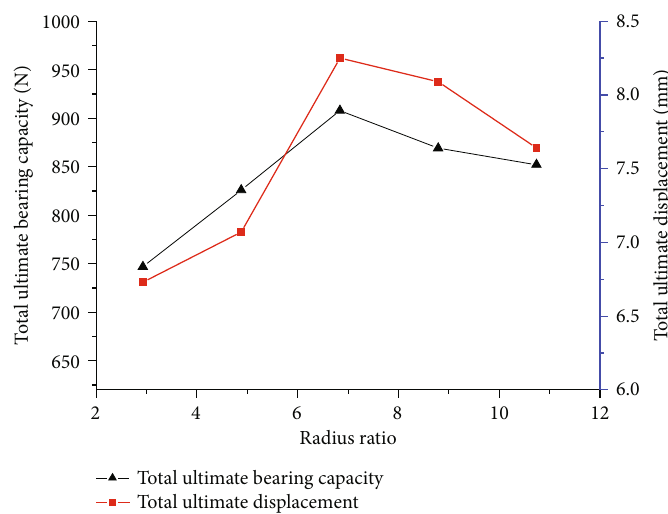
R . two ) and total limit displacement vs.